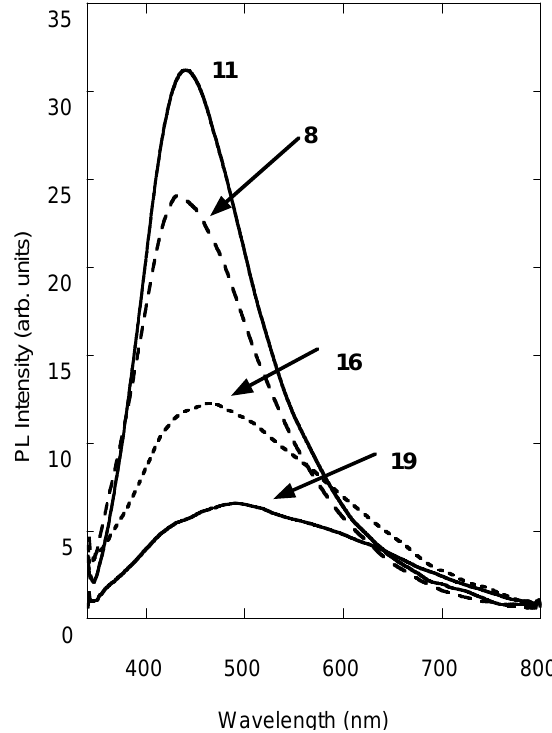
Figure 3. PL spectra of 8-hydroxy-7-methoxy-4-methylcoumarin derivatives ( 8 , 11 , 16 and 19